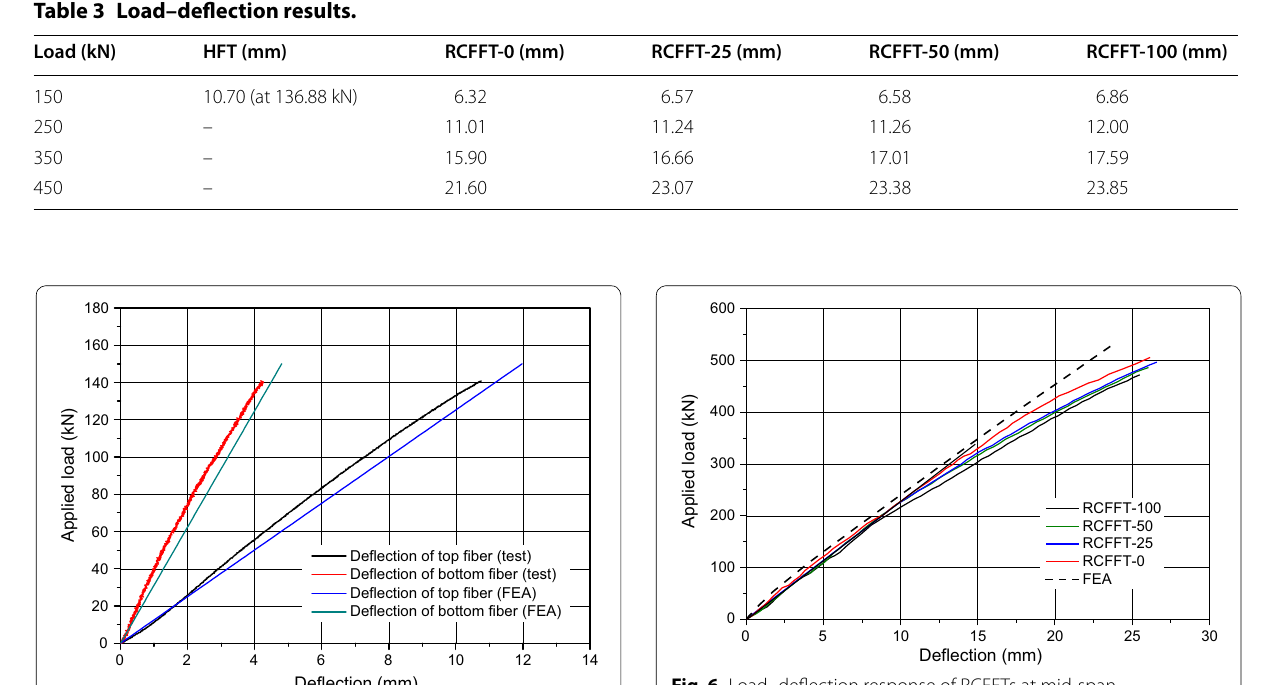
Fig. 6 Load–deflection response of RCFFTs at